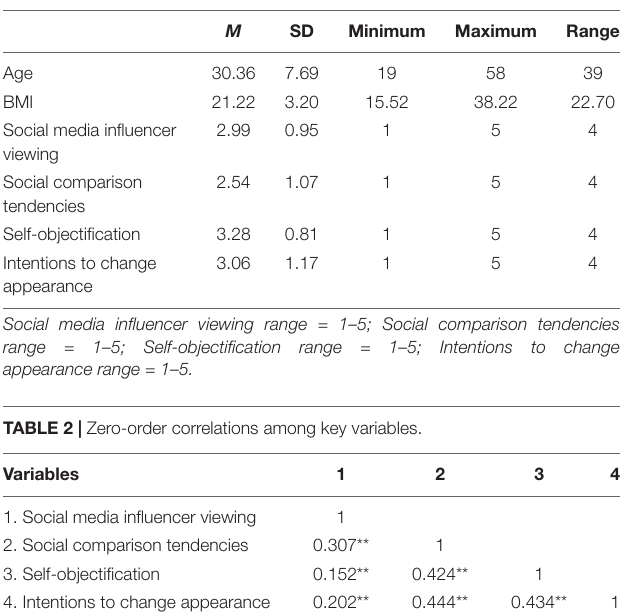
TABLE 1 | Means and standard deviations of key variables.